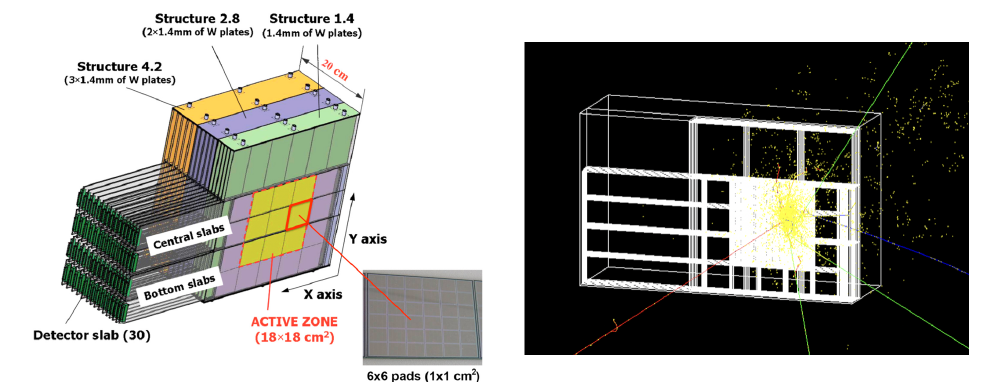
Figure 6. Left : Scheme of the CALICE SiW detector prototype from [17]. Right : Graphical represen- tation of the Geant4 simulation of a π − event interacting in the calorimeter via a nuclear inelastic process. See text for